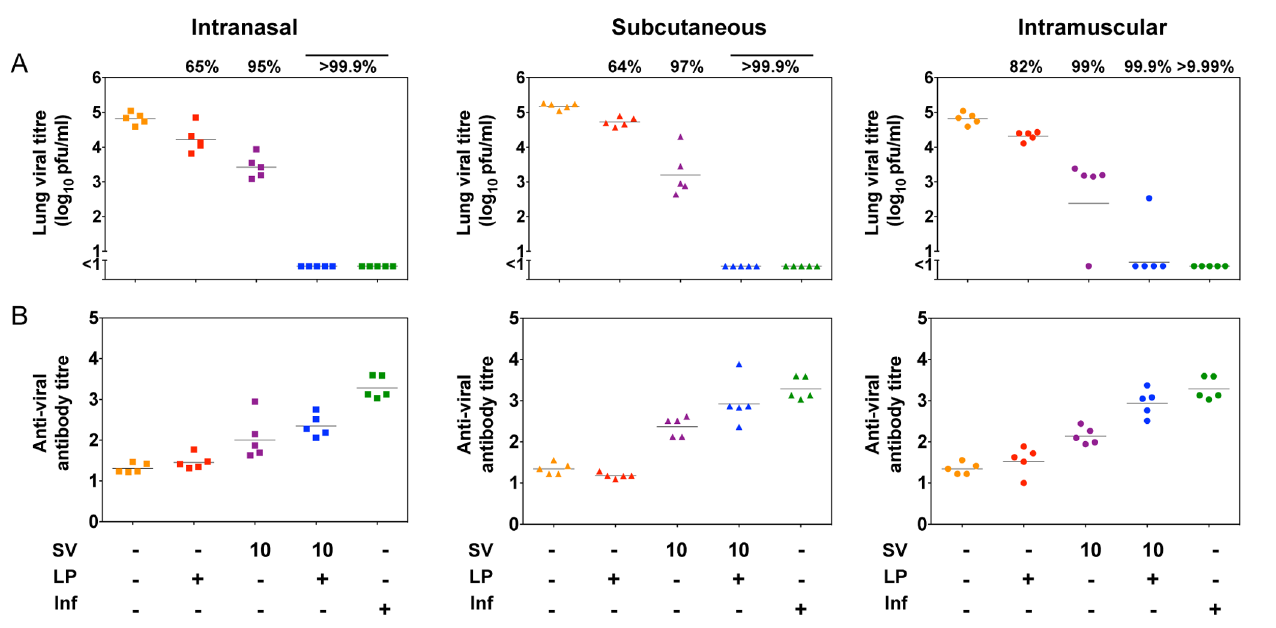
Fig. 2. Viral clearance and antibody titre induced by immunisation with the high dose combination vaccine and its individual components. Mice were immunised once by the i.n. (squares), s.c. (triangles) or i.m. (circles) routes with 10 nmol lipopeptide (LP), 10 m g of HA as split virus (SV) or a combination of both components as indicated ( + ) or infected with 10 4.5 pfu of virus (Inf). Control mice received PBS. One month post-immunisation, mice were challenged by the i.n. route with 10 4.5 pfu of virus, lungs were removed 5 days later and pulmonary viral titre determined by plaque formation (A). Mice were bled prior to challenge, and the virus-specific antibody response in sera measured by ELISA (B). Symbols represent the titres for individual mice, and the line indicates the geometric mean for the group (n 5 5). The numbers above the data sets refer to the average percentage decrease in viral load compared to PBS control